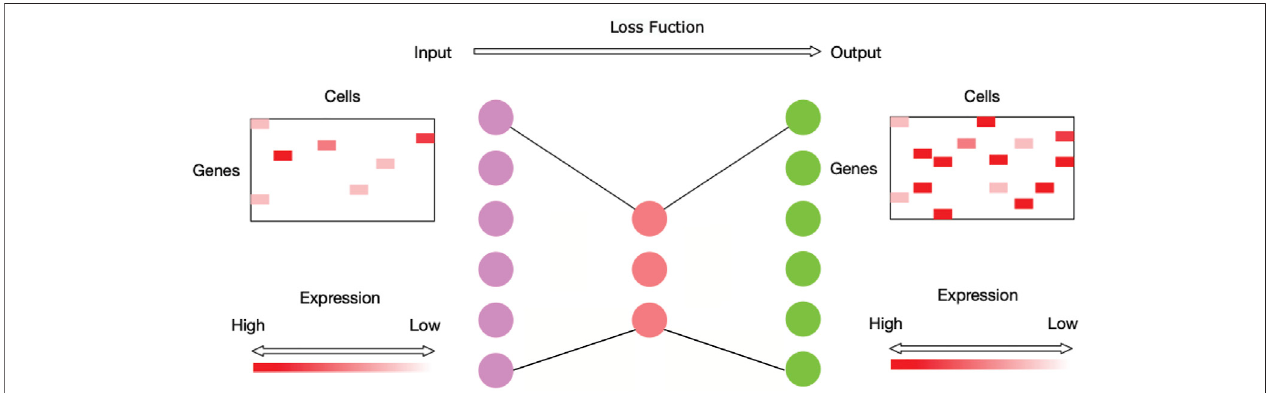
FIGURE 1 | Neural network architecture of NISC. This network is mainly composed of three hidden layers (i.e., dots with three different colors, purple, red, and green).The fi rsthiddenlayer hasneuronsequal totwice thenumber ofgenesoftheinputdata. Itisfollowed bythesecondhiddenlayerinthe middle with neurons equal to around half the number ofgenes ofthe input data. The third layer has neurons equal to the number of neurons of the fi rst layer. This neural network is trained using an optimization process with a loss function to calculate the model